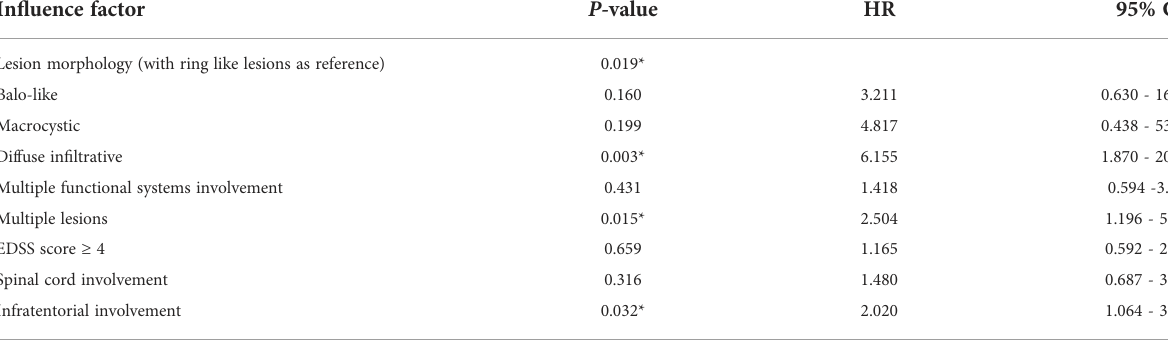
TABLE 2 Multivariate analysis of risk factor screening for relapse of TDLs.